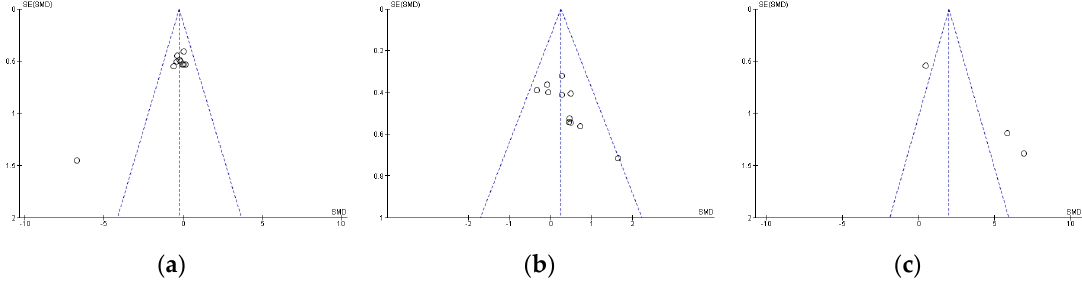
Figure 1. Standard error for Times Trial Test ( a ), Limited Time Test ( b ), and Limited Distance Test ( c ). SE: standard error; SMD: standardized median difference.